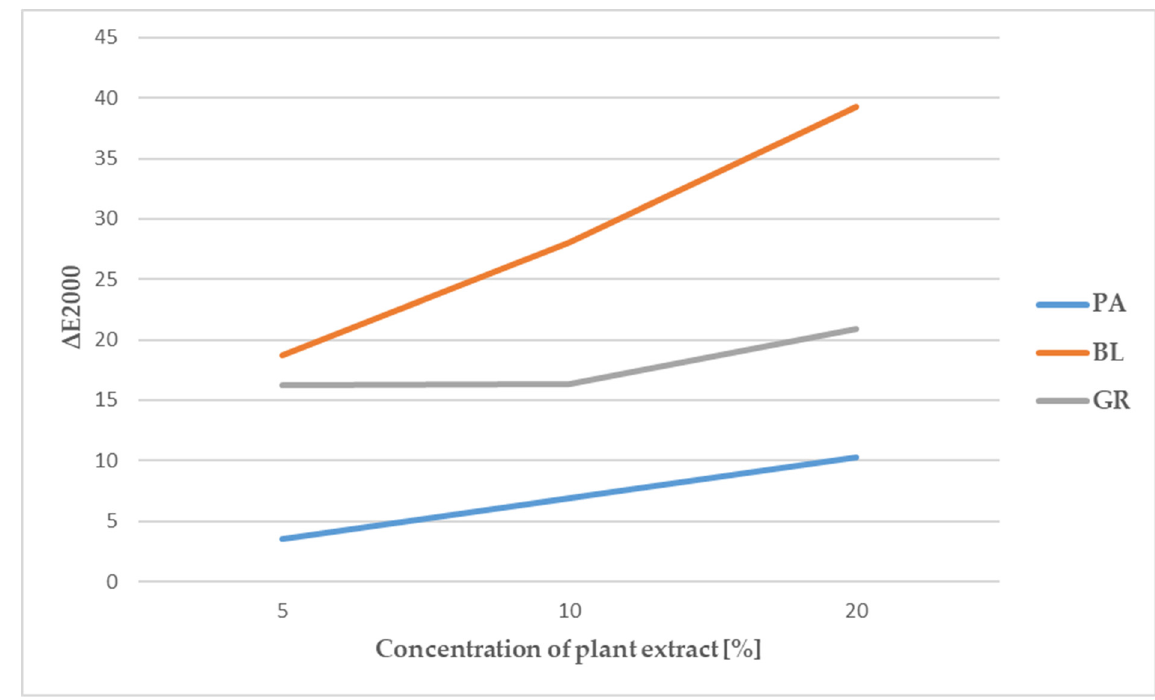
Figure 4. Colour difference between the control and the edible coating samples with added extracts (PA, parsley extract; BL, blueberry extract; GR, grape extract).